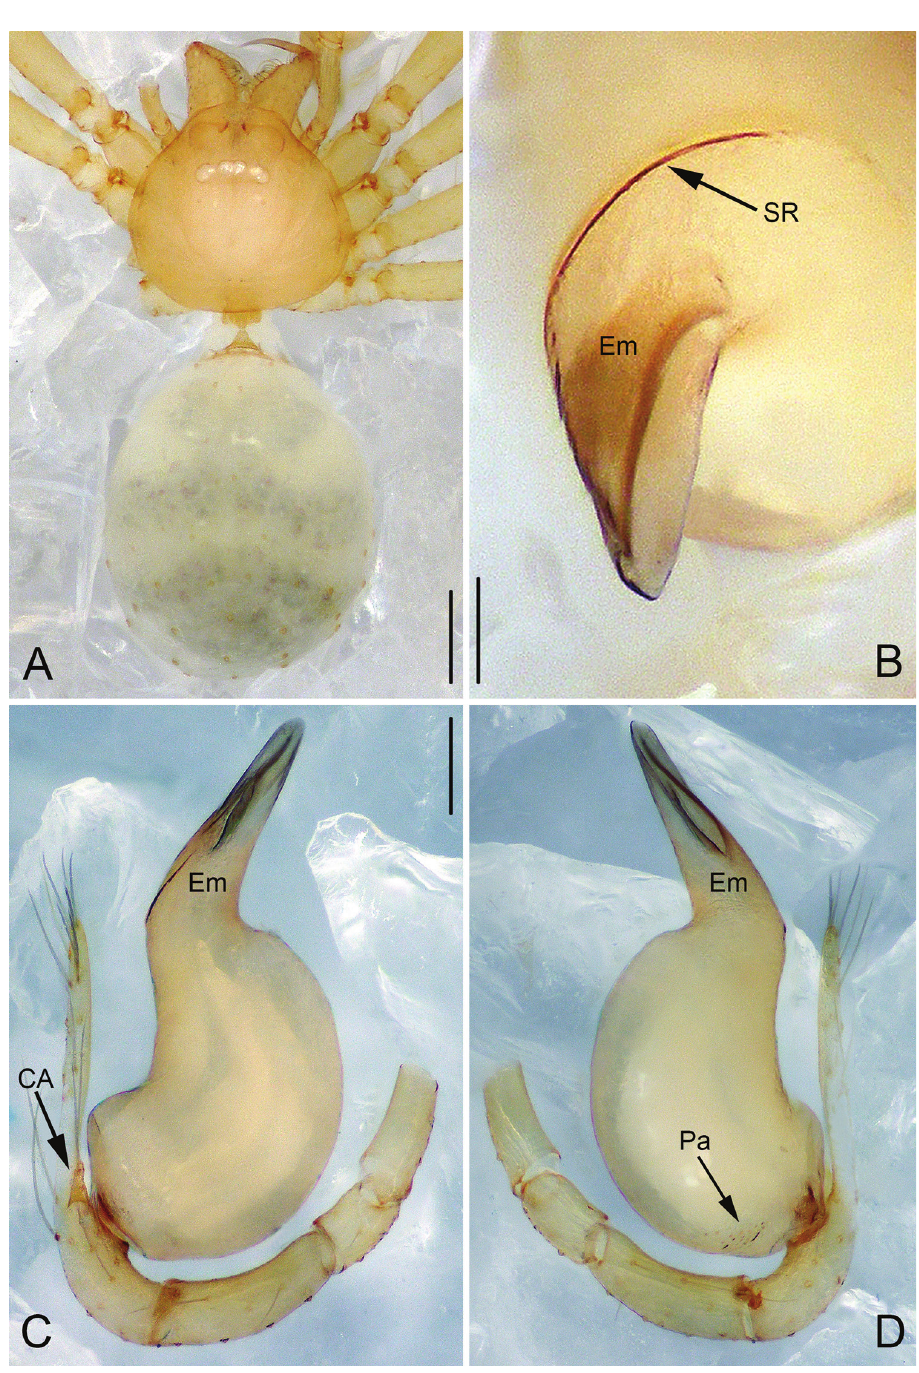
Figure 3. Pinelema podiensis sp. n., male holotype. A Habitus, dorsal view B Tip of embolus, apical view C Palp, prolateral view D Palp, retrolateral view. Scale bars: 0.2 mm ( A ), 0.05 mm ( B ), 0.1 mm ( C–D